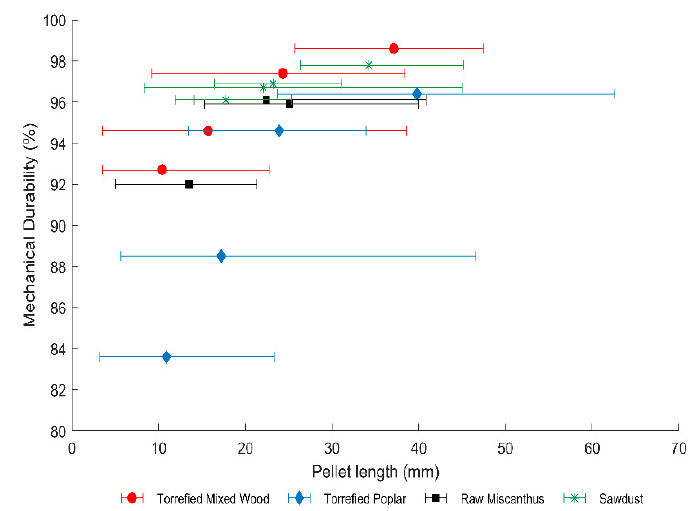
Figure 8. Mechanical durability values of torrefied mixed wood pellets versus the L 50 of various length distributions. Error bars show the standard deviation.